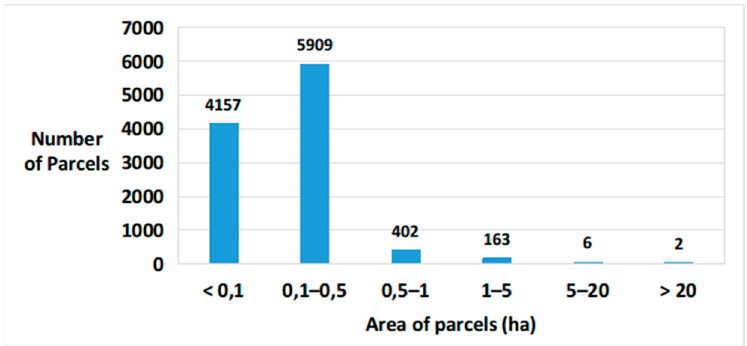
Figure 3. Number of parcels in Lis Valley Irrigation District (LVID) by classes of area.